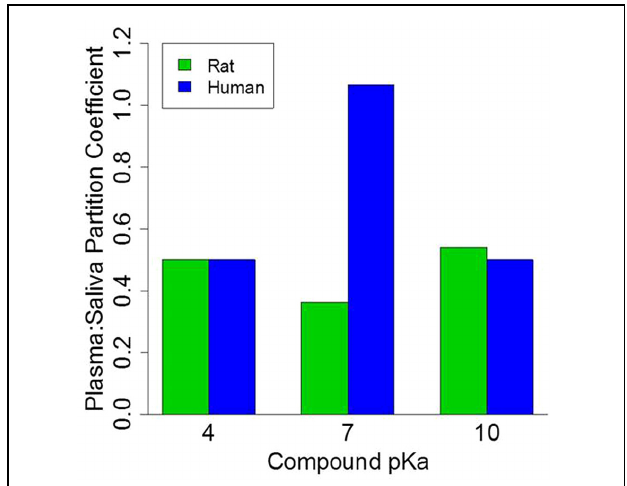
FIGURE 5 | Physiologically based pharmacokinetic model simulation of plasma:saliva partitioning coefficients for three generic compounds with varying pKa values. Protein binding set at 50%.